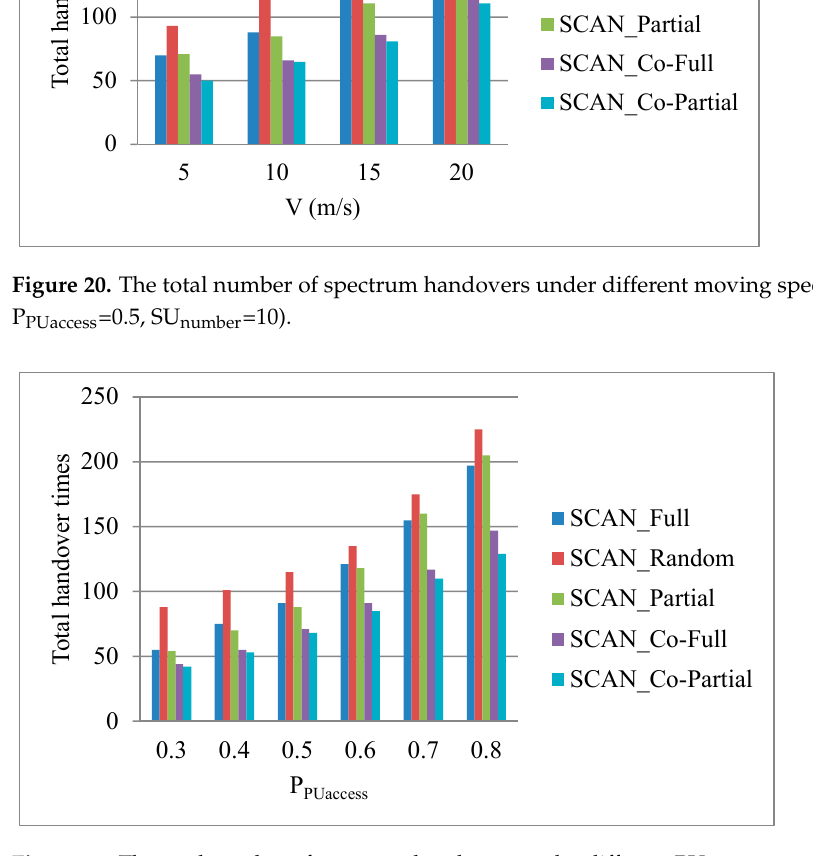
Figure 21. The total number of spectrum handovers under different PU cars access network probabilities (PU number = 10, V = 10, SU number = 10).